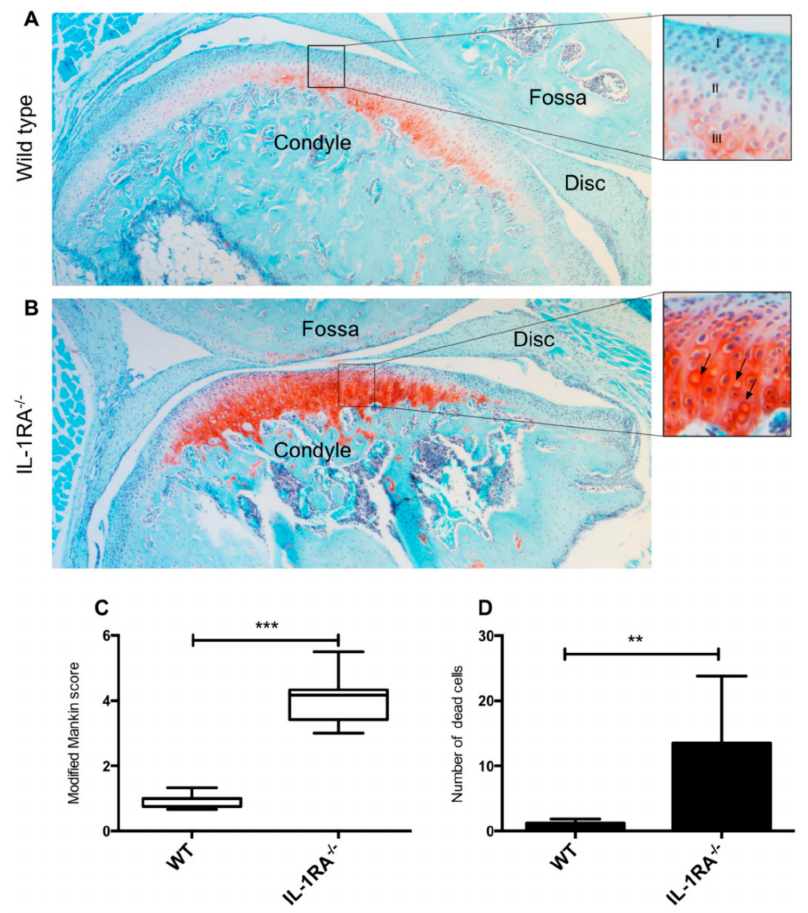
Figure 1. Histologic assessment of the temporomandibular joint (TMJ) of IL-1 receptor antagonist (IL-1RA − / − ) and wild-type (WT) mice. Sagittal section of the condyles of IL-1RA − / − and WT mice stained with Safranin O. ( A ) WT TMJ, original magnification 10 × . The condyle cartilage can be